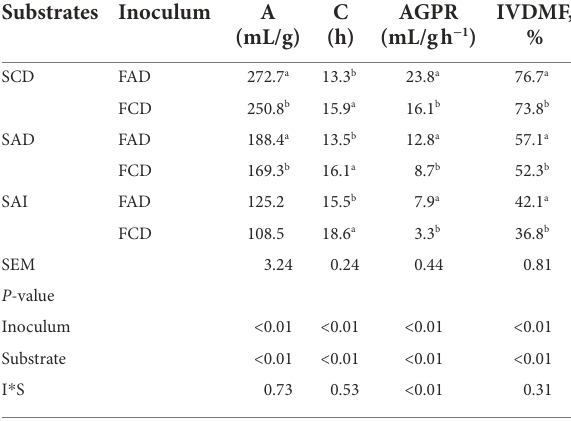
TABLE 2 Gas fermentation parameters (A, C, AGPR) and IVDMF of in vitro fermentation using inoculum prepared by feces from pigs fed CD or AD